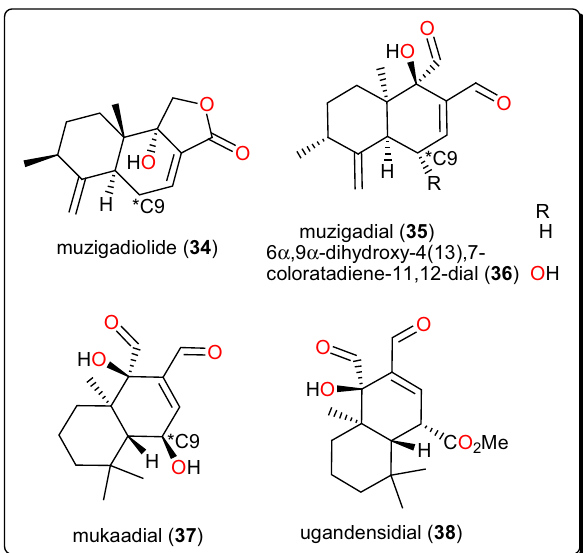
Fig. 6 Sesquiterpenoids which have demonstrated anti- Trypanosoma